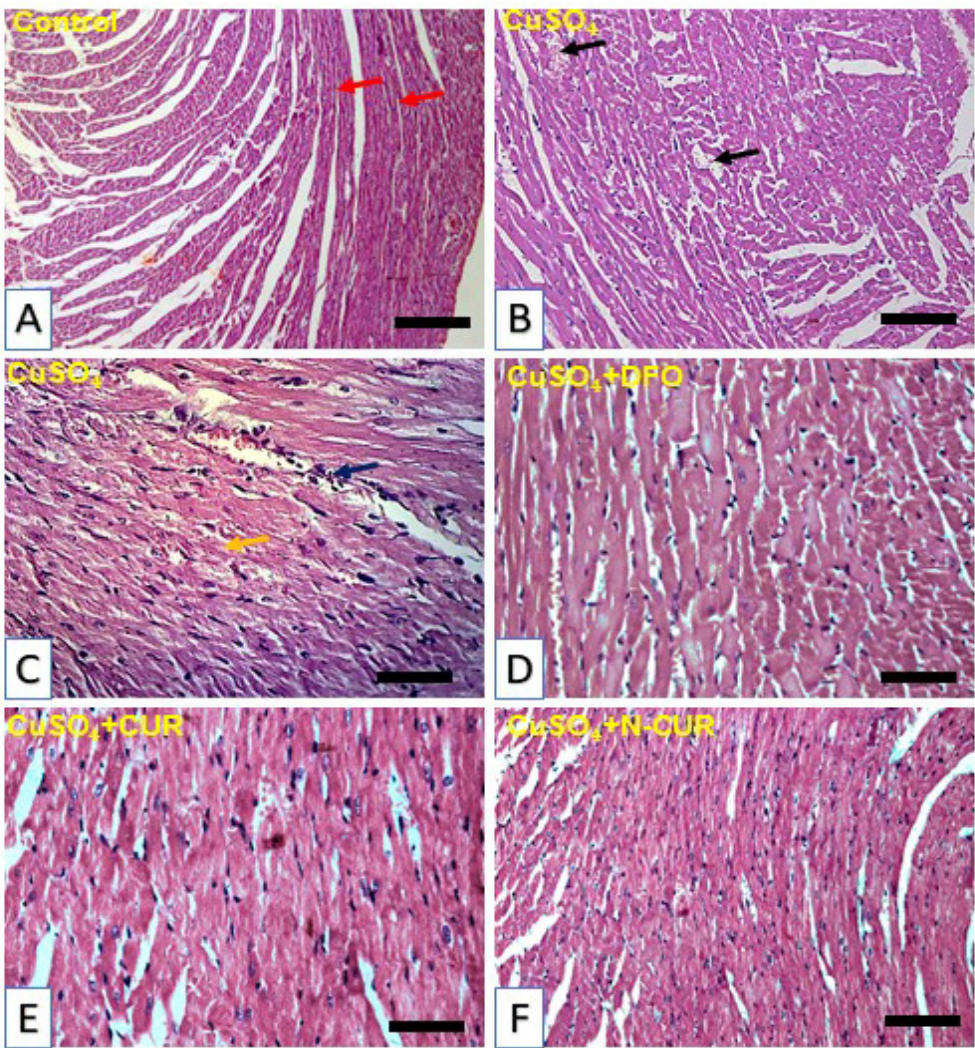
Figure 2. Photomicrographs of H&E-stained sections in the heart of ( A ) control rats showing normal histological structure of the cardiomyocytes (red arrow), ( B , C ) CuSO 4 -intoxicated rats showing blood vessel congestions (black arrow), inflammatory cell infiltration (blue arrow) and degenerative changes (yellow arrow), ( D , F ) CuSO 4 -intoxicated rats treated with deferoxamine (DFO) ( D ), curcumin (CUR) ( E ), and nano-CUR (N-CUR) ( F ) showing no histopathological alterations. (Scale bar = 50 µm, − 400X).